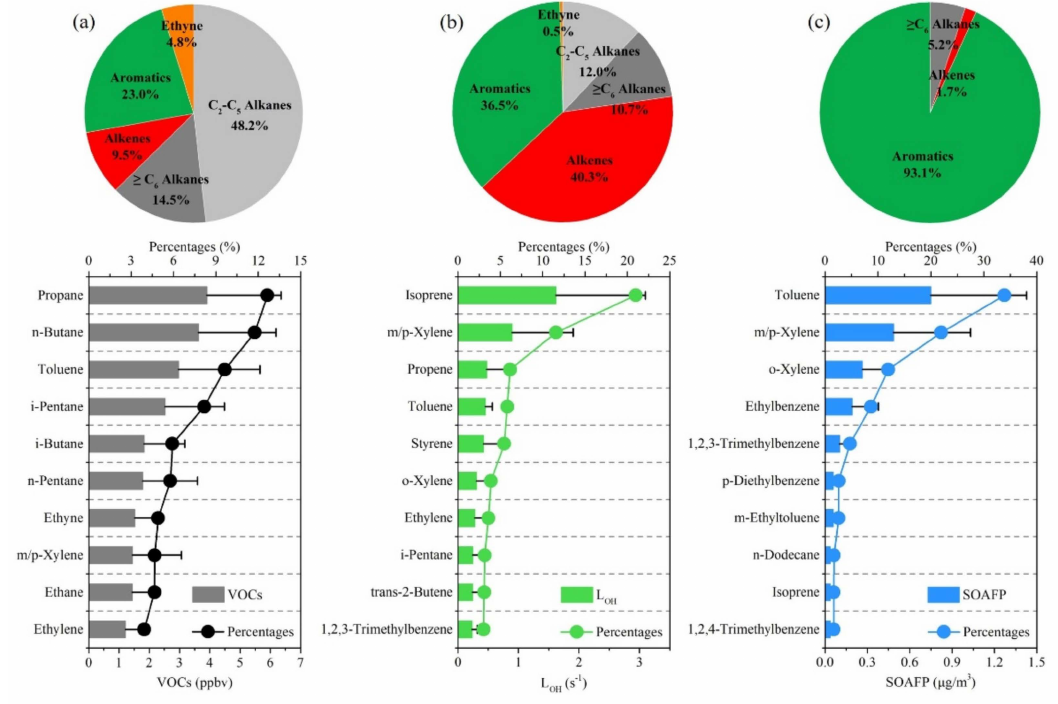
Figure 3. Composition and top ten species of ( a ) VOCs, ( b ) L OH , and ( c ) SOAFP, respectively. The mixing ratio of VOCs averaged 31.80 ± 20.82 ppbv in this study. Compared with the data reported in other studies from around the world (Table 1), the mixing ratio of VOCs in urban Guangzhou in this study was comparable with previously reported levels in Wuhan, China during January 2016 (32.07 ppbv) and Colorado from March–May 2015 (32.10 ppbv) [56,57], higher than those over Beijing from October–November 2014 (23.41 ppbv), Tianjin from June to August 2018 (14.10 ppbv), Shanghai from January 2007 to March 2010 (25.59 ppbv), and Guilin from May to November 2018 (21.79 ppbv) [58–61],